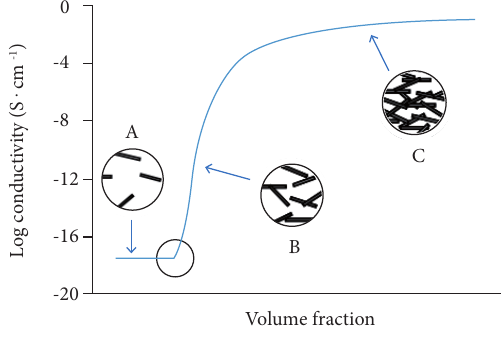
Figure 2. The dependence of electrical conductivity on the filler content (McCullough 2000).